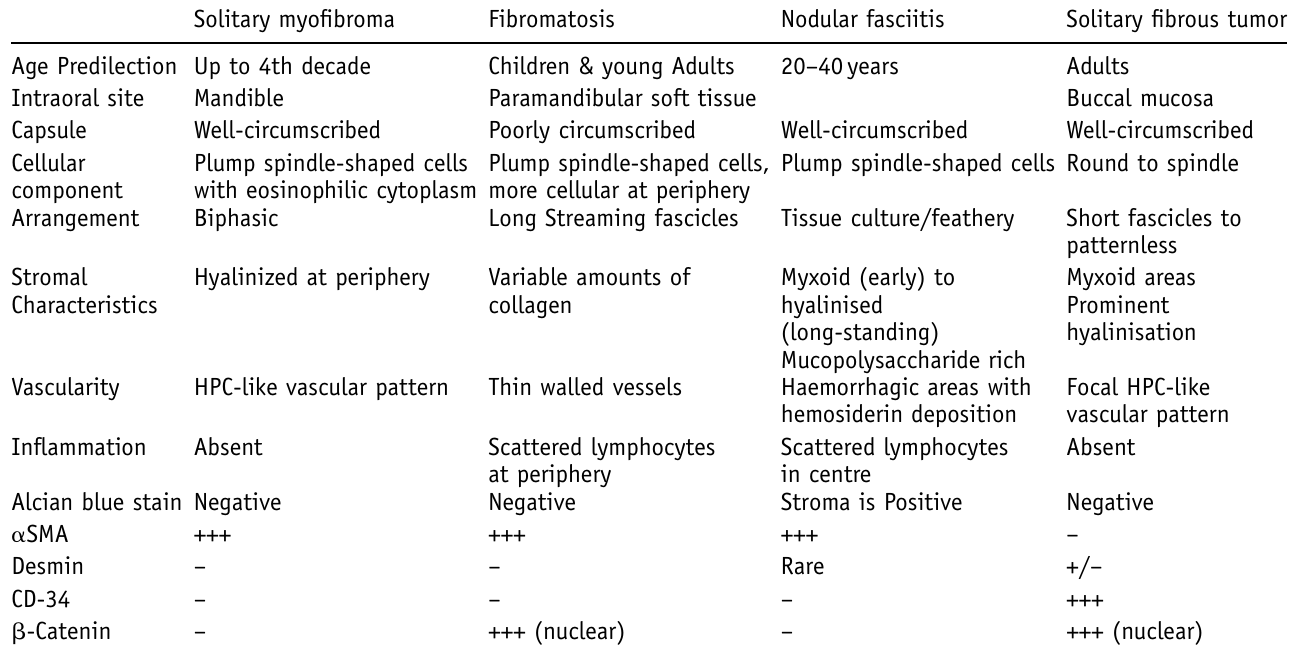
Table I. Clinical and pathological characteristics of benign spindle cell